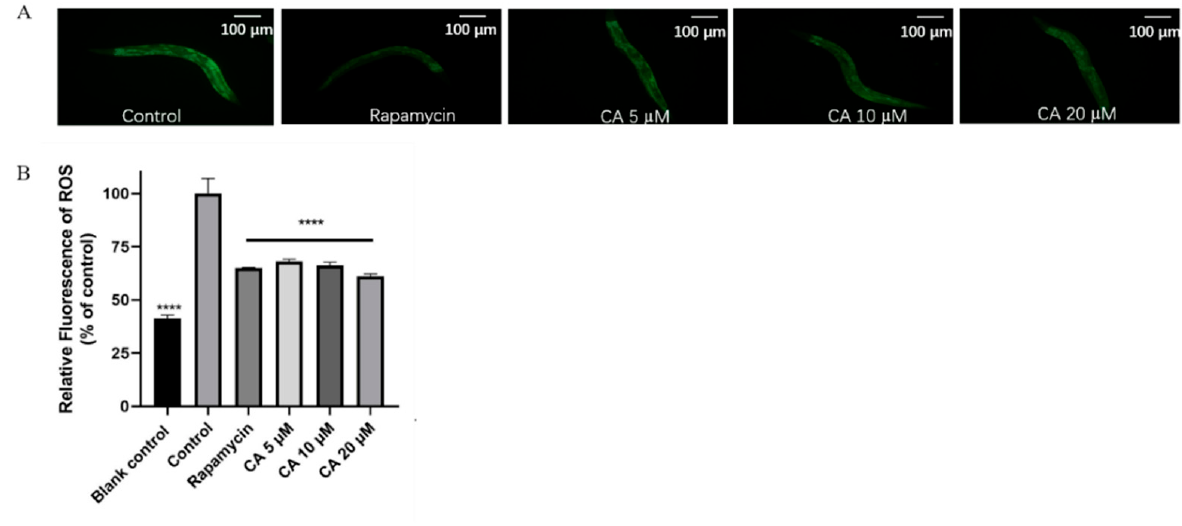
Figure 4. Effect of CA on intracellular ROS accumulation in C. elegans . Representative fluorescence images of worms, scale bar = 100 μ m. ( A ) Relative fluorescence levels of ROS under oxidative stress compared with that in control (( B ), n > 150, **** p < 0.0001). Data were obtained from the Biotek microplate reader.